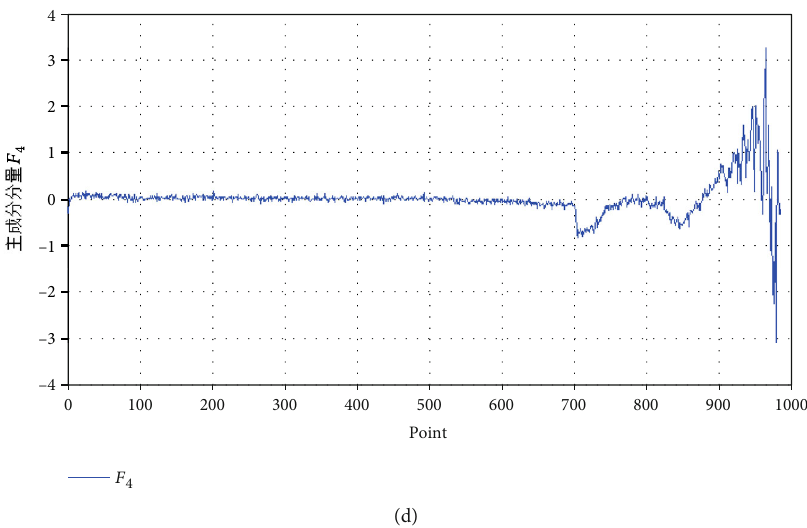
Figure 8: Performance decline curve of principal components F